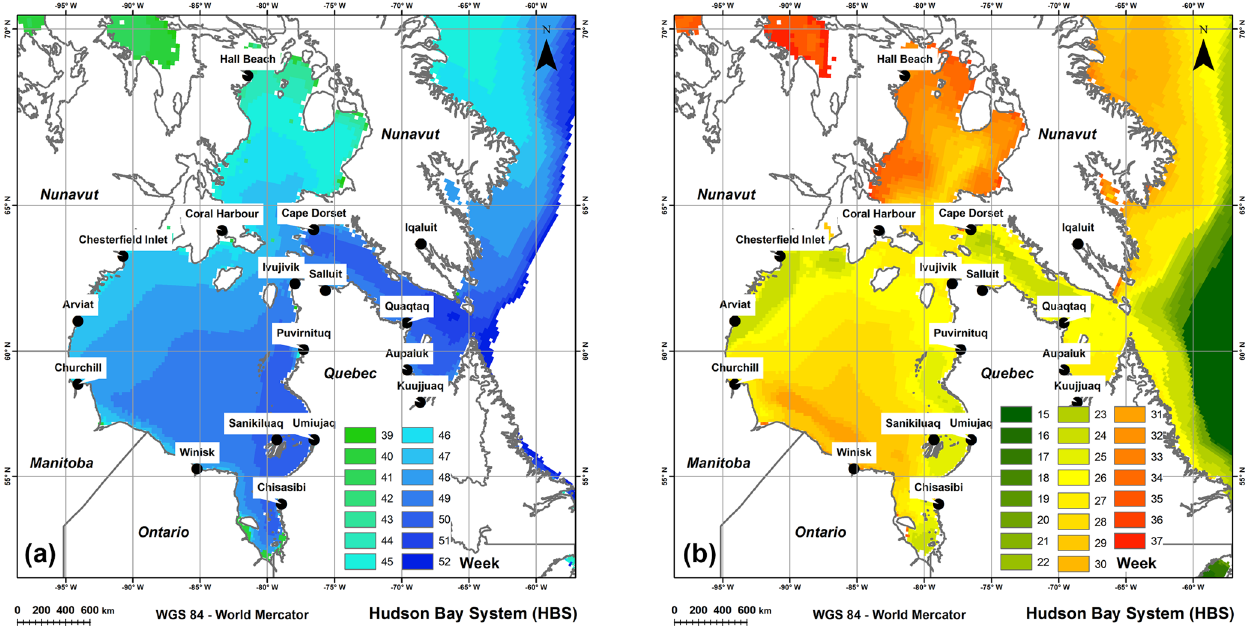
Figure 8. Estimated freeze-up (a) and melt-out (b) weeks for p = 50% in the